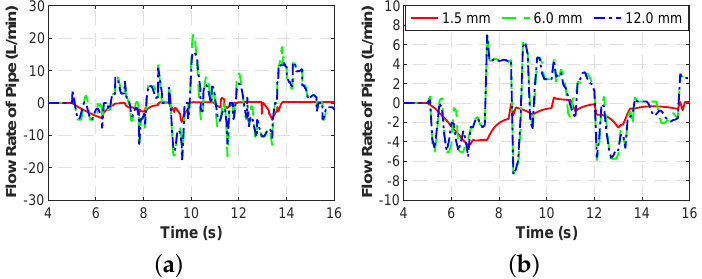
Figure 13. Flow rate comparison of different pipe diameter: ( a ) Trapezoidal barrier traversing ( b ) Step barrier